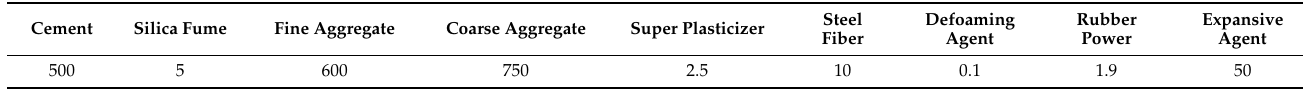
Table 3. Mixture properties of the ESS-HPC matrix (kg/m 3 ).